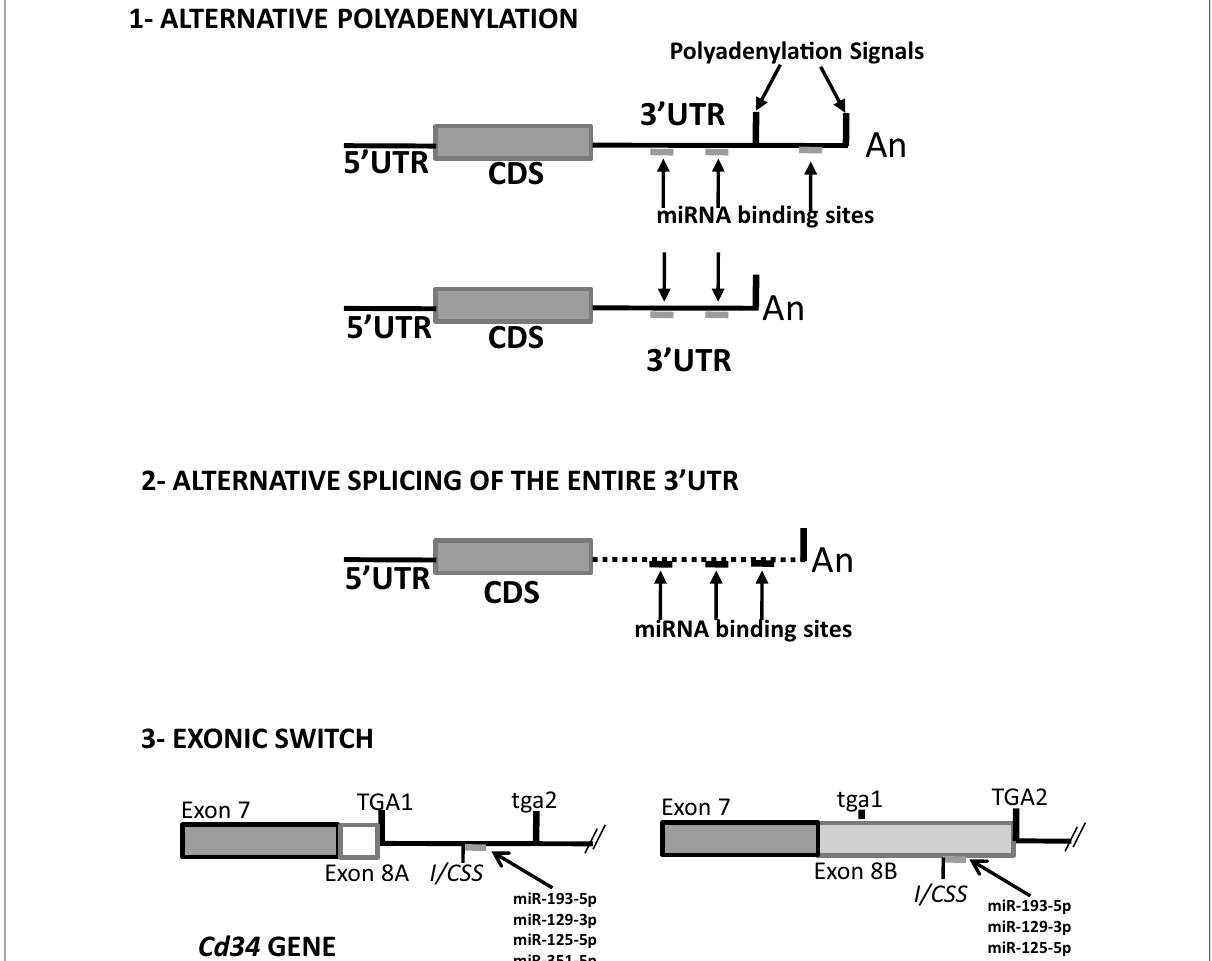
Fig. 2 Impact of alternatively expressed 3 ′ UTRs on their interaction with miRNAs. Shown are changes in the structure of the 3 ′ UTRs with the potential to impact on the binding of specific miRNAs. 1 . The existence of alternative polyadenylation signals originate 3 ′ UTRs of different lengths and different potential for miRNA binding. 2 . Alternative exons encoding different 3 ′ UTRs differ in their potential for miRNA binding. 3 . Exonic switch. In the case of the Cd34 gene, an internal cryptic splice site (CSS) activates two different stop codons and generates two different exons 8, with the consequence that in one Cd34 isoform the binding site for a number of miRNAs is located in the 3 ′ UTR, while in the other isoform it is located inside the CDS (taken from